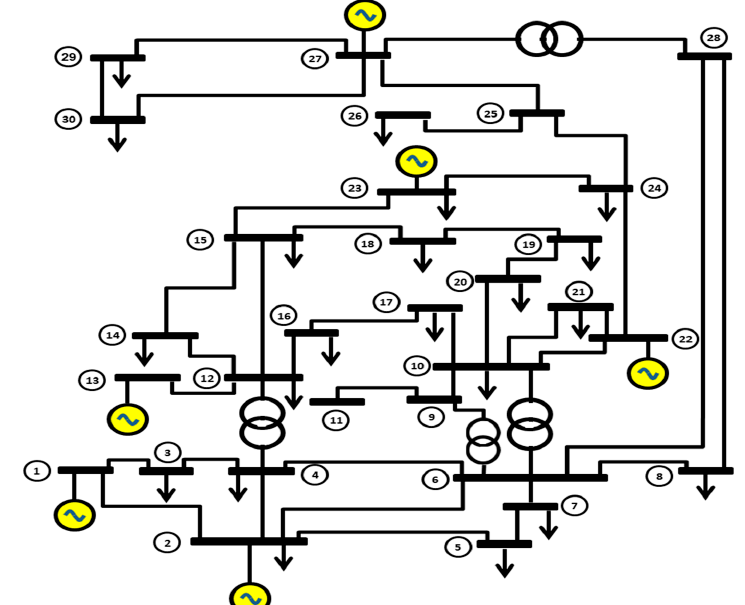
Figure 4 The IEEE-30 bus test system. Figure 4. The IEEE-30 bus test Table 2. Generator data of the IEEE-30 bus test system [39]